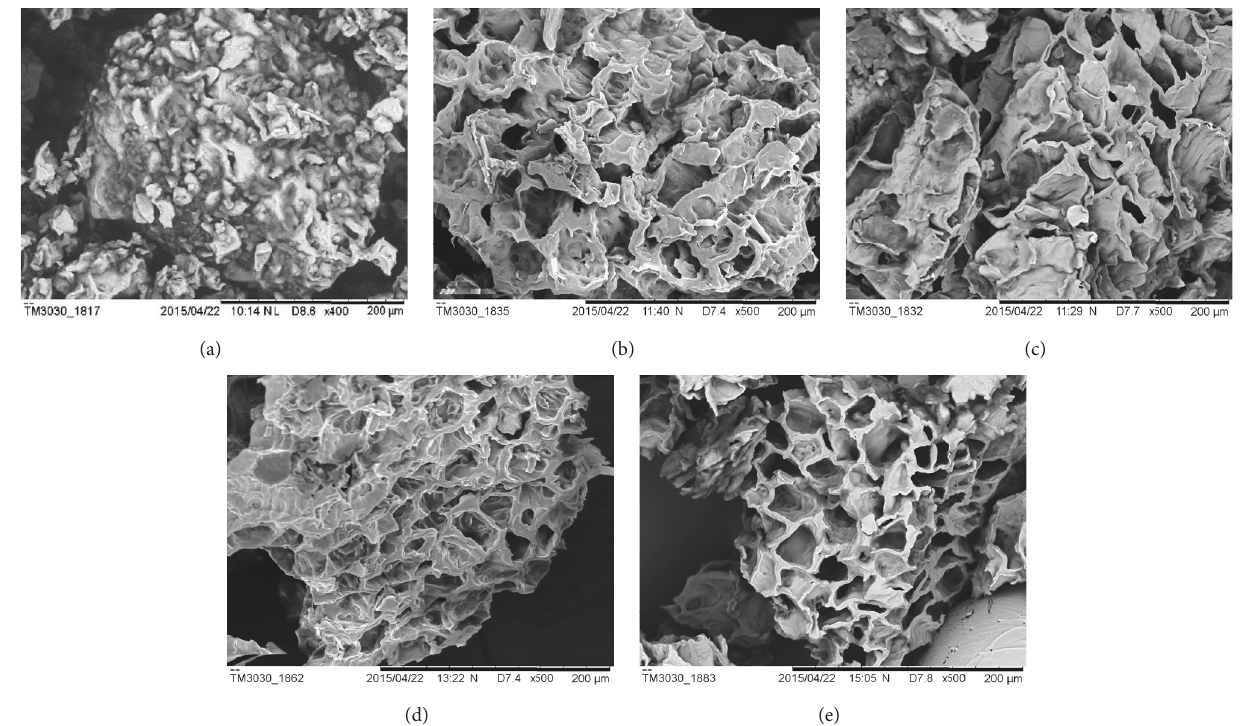
Figure 4: SEM image of (a) 0 hr, (b) 1 hr, (c) 6hr, (d) 12hr, and (e) 24 hr of 1% NaOH treated GCW.